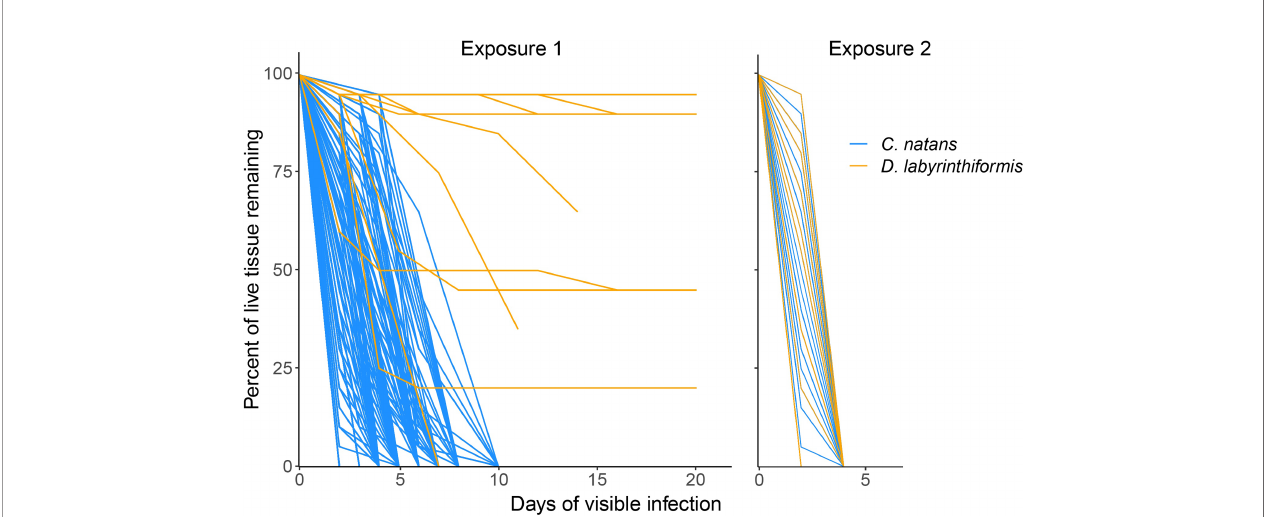
FIGURE 5 | Loss oftissue overtimeinbraincoralrecruitsexposedtoSCTLD.Onlythoserecruitsthat developedlesionsareshown.Lines representindividualrecruits after developing lesions(althoughmanyoverlapwithoneanother due tosimilarpatterns oftissue loss).Day0representsthelastdaythatagivenrecruitwasobservedto beapparently healthyandhave100% ofitstissue. Exposure1 represents60.8%ofrecruitsindiseaseaquaria, whilepanelExposure2 representstheremaining 39.2%. The linesrepresenting some D. labyrinthiformis recruitsinExposure1endbeforereaching 0% tissuebecause theremainingtissuelossoccurredafter thesecondexposurewasdelivered.